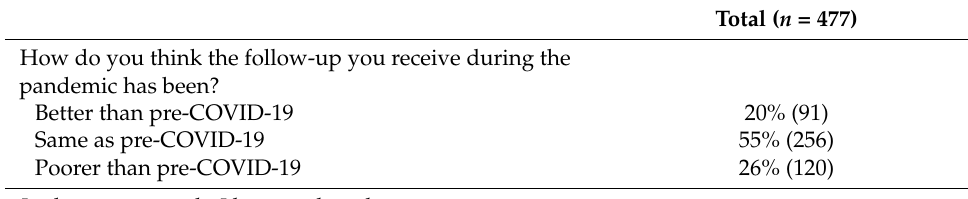
Table 2. Compliance towards COVID-19 preventive measures, testing and test results and social consequences of the pandemic in a sample of 477 PWUD.